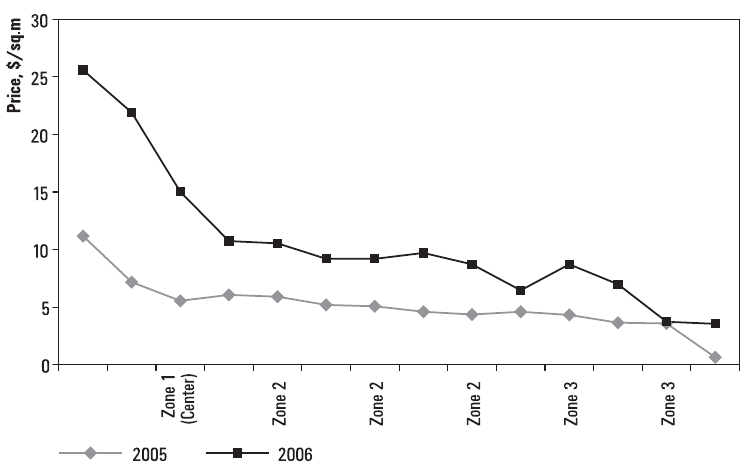
Figure 1. Auction prices by zone and year, Jalalabat